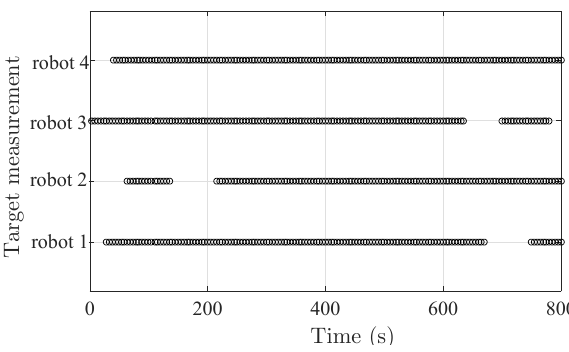
Figure 3. Measurement availability of target to four robots with r t =